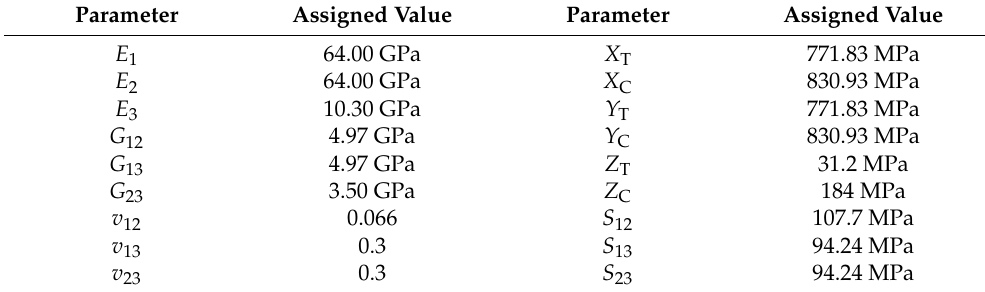
Table 3. Composite model parameters.